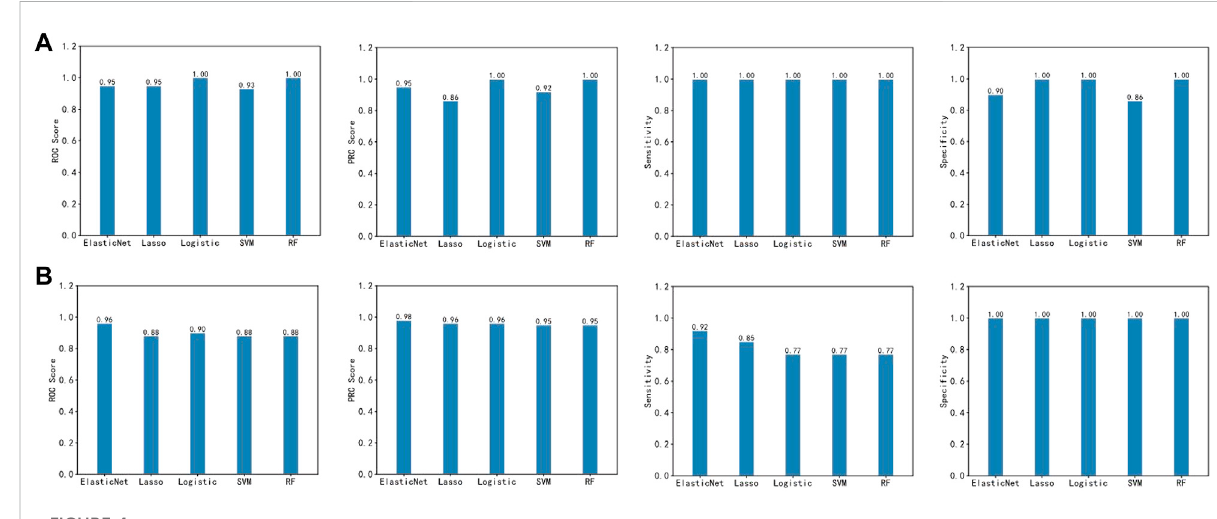
FIGURE 4 Prediction performance of the fi ve machine learning methods in the training set (A) and the validation set (B) .